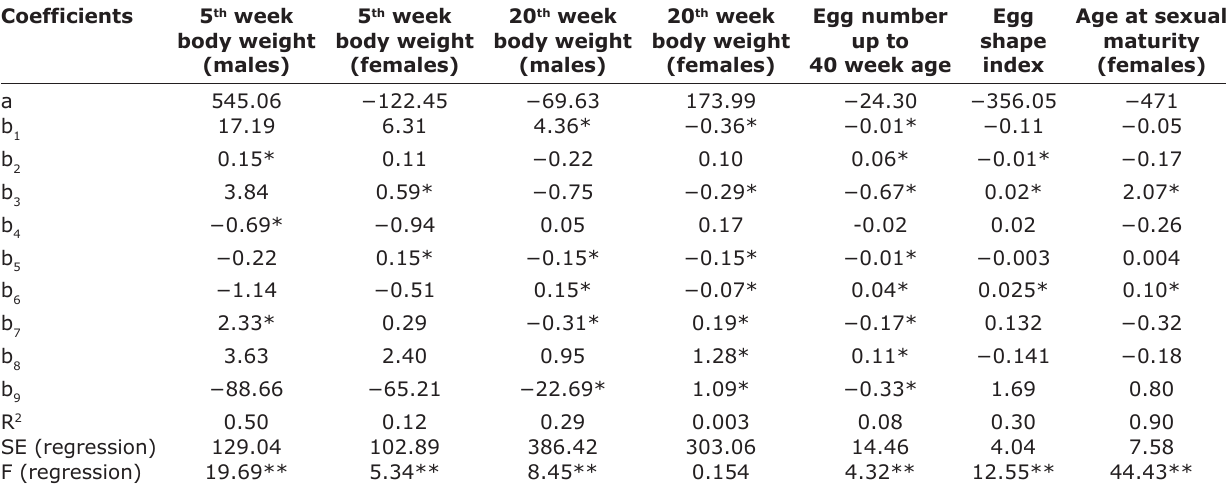
Table-3: Multiple linear regressions on production and reproduction traits of environmental variables in broiler breeder poultry.